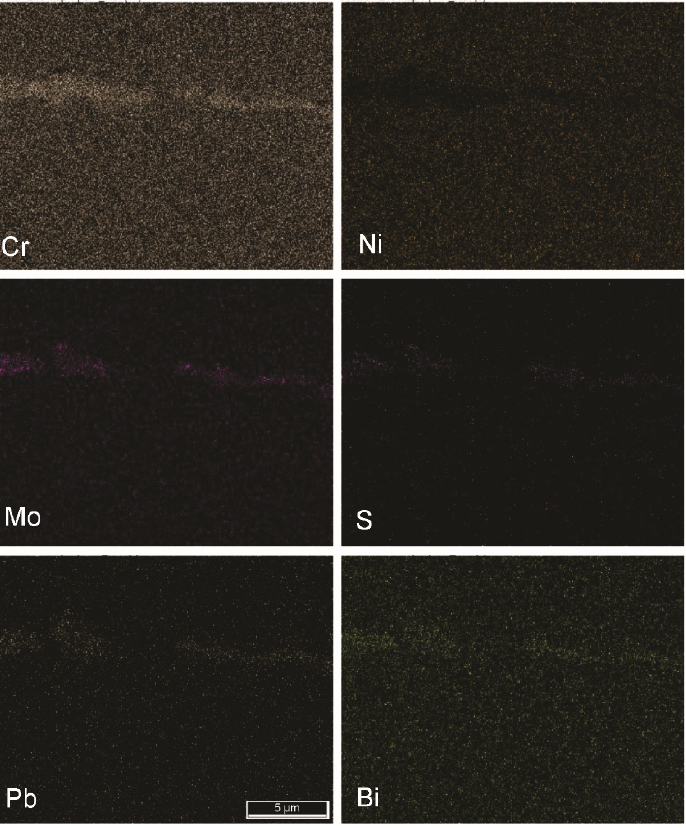
Figure 10. Segregation of Cr, Mo, S, Pb, and Bi in the hot-rolled plate of steel A (FE-SEM-EDS; mag. 5000×).